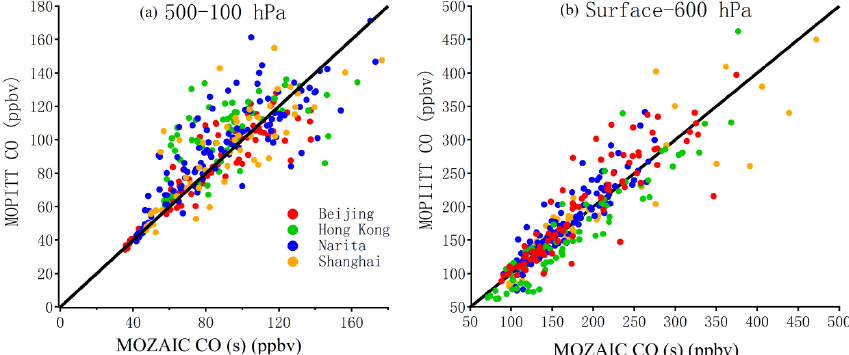
Figure 3. Correlation between MOPITT and MOZAIC data (smoothed with the MOPITT averaging kernels, see Eq. 1) from 2003 to 2005 at Beijing, Narita, Shanghai, and Hong Kong (a) from the middle to upper troposphere and (b) from the surface to the middle